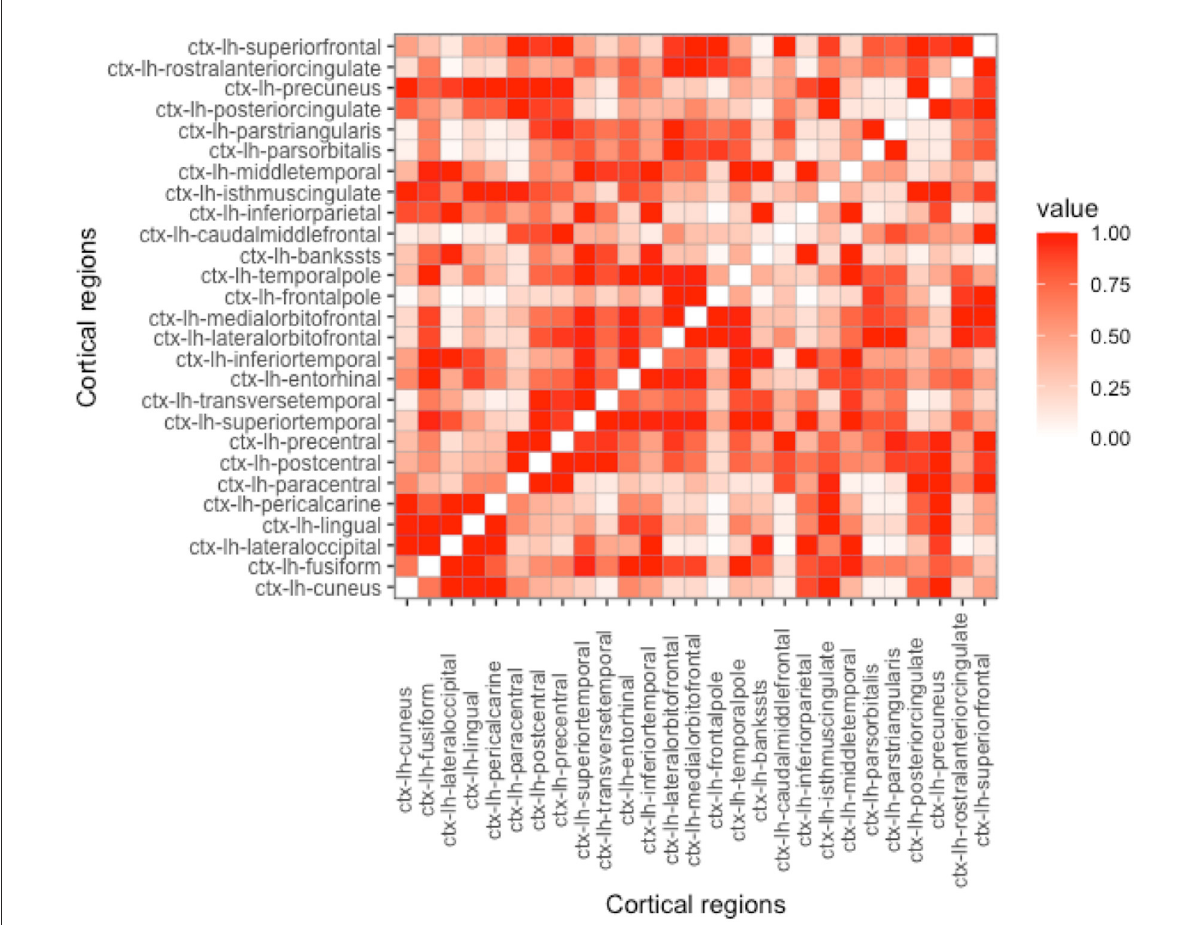
FIGURE3 Proximity matrix displayed for the left hemisphere, geodesic distance, and parameter h the Supplementary